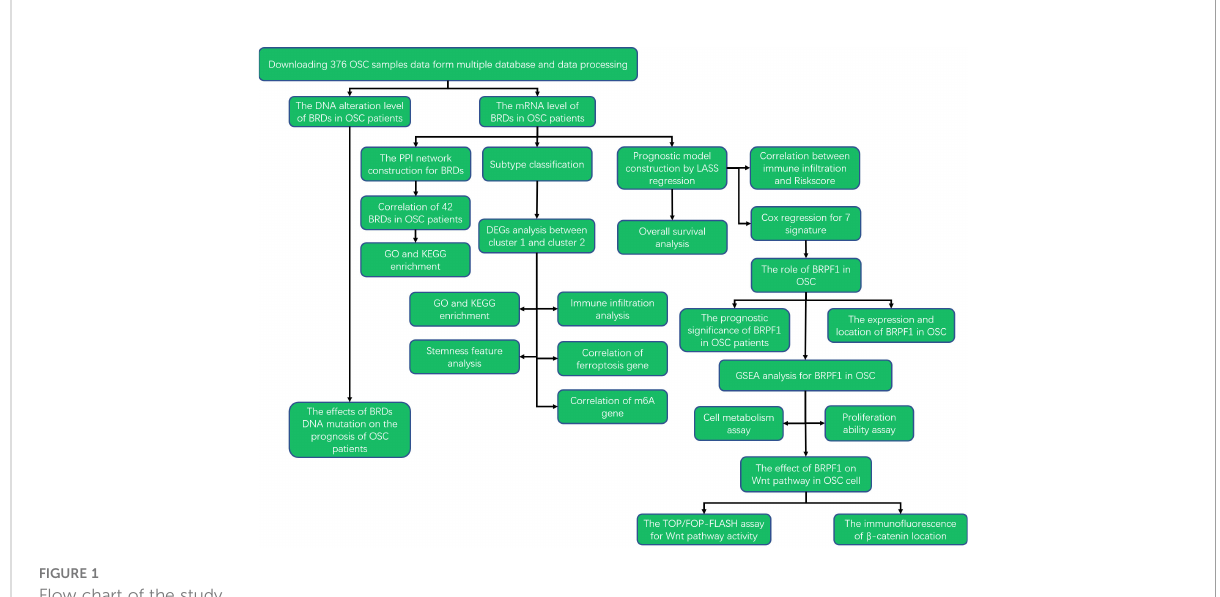
FIGURE 1 Flow chart of the